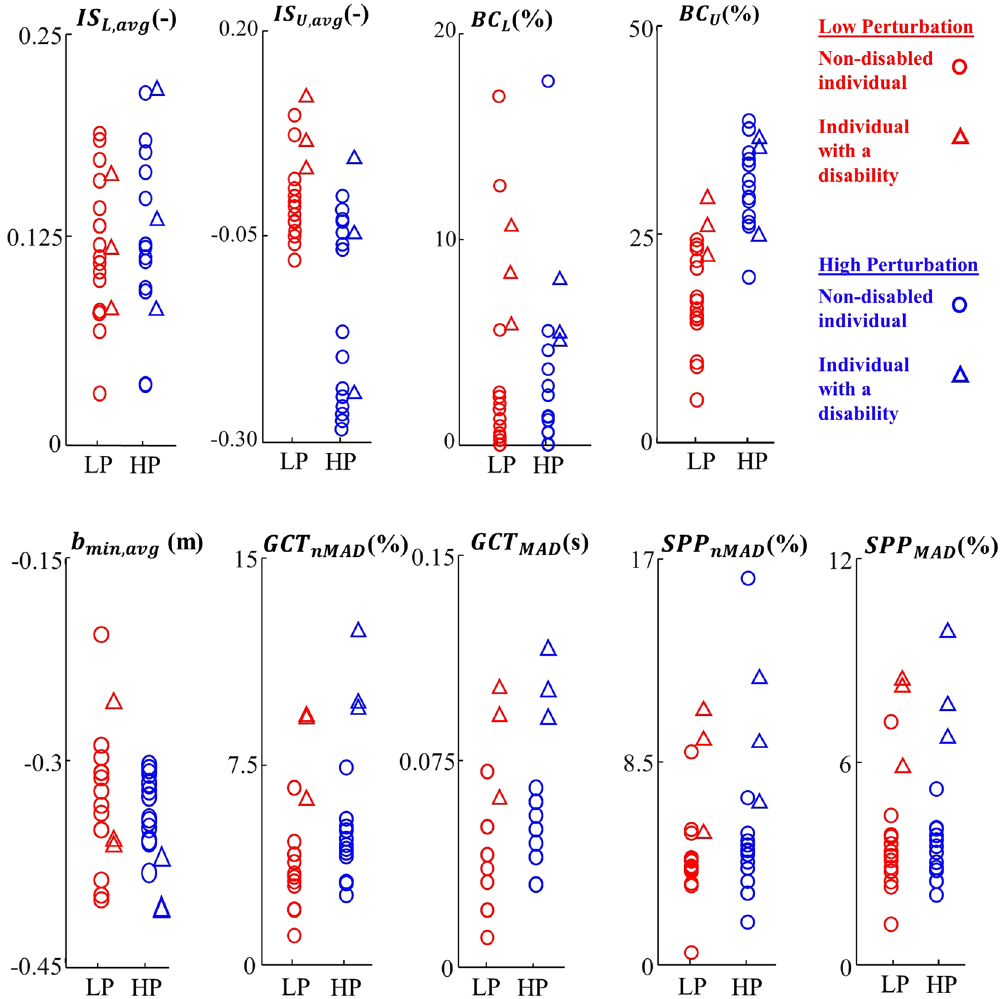
Figure 3. Stability measures obtained using experimental data. Our proposed measures ( IS L,avg and IS U,avg ), BC L and BC U , XCOM-based biomechanical measure ( b min,avg ), and variability measures ( GCT nMAD , GCT MAD , SPP nMAD , and SPP MAD ) are presented for non-disabled participants (circle) and participants with disability (triangle), for low-perturbation ( LP , red) and high-perturbation ( HP , blue) walking trials.